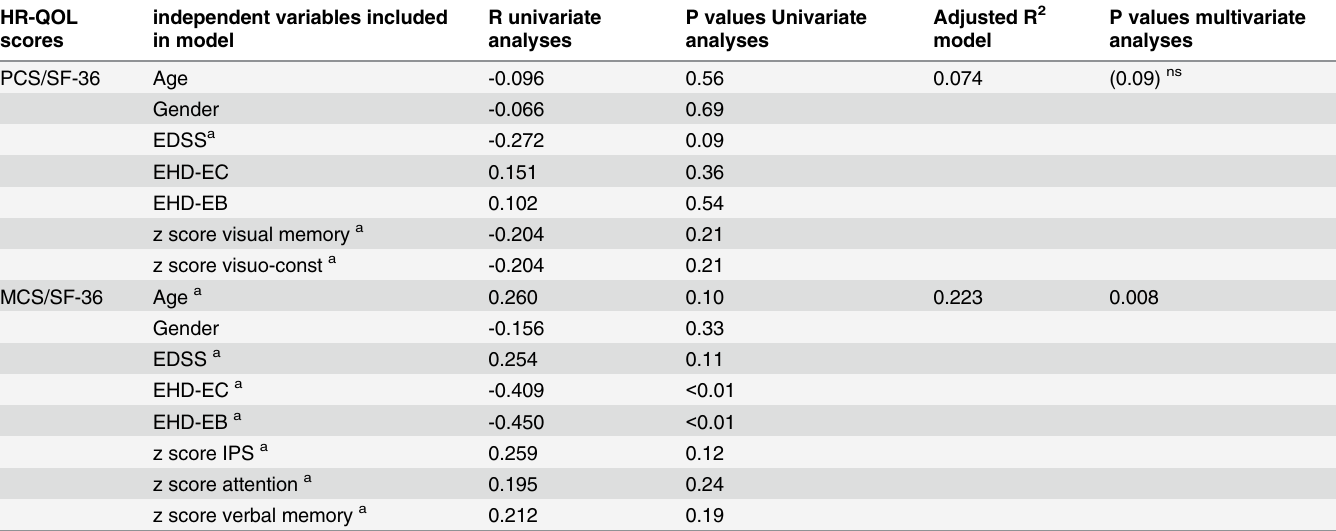
Table 5. Multivariate analyses of HR-QOL in PPMS patients (models including EHD PRO-subscales). HR-QOL